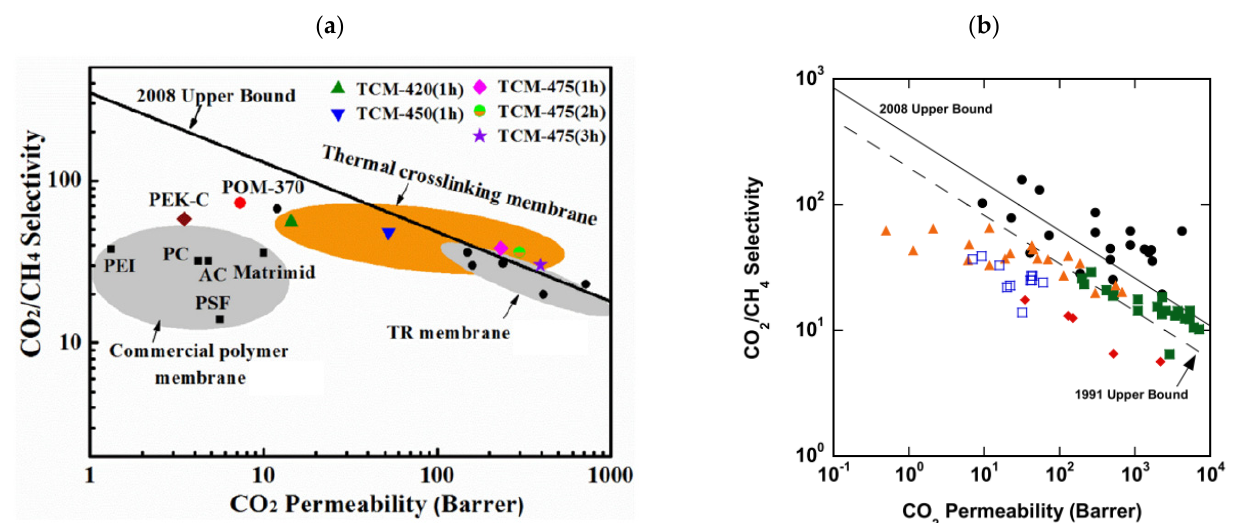
Figure 9. Illustration of thermal cross-linking and TR membranes on the 2008 upper Robeson plot. ( a ) POM-370—(TR PEK-C with oxidative pretreatment; TCM-X(y)—(TR PEK-C with thermal treatment at x °C (y hours), [103] ( b ) CO 2 /CH 4 separation performance of several polymer materials described in the literature. TR polymers ( ● ), PIMs ( ■ ), Perfluoropolymers ( ◆ ), Polyimides ( ▲ ) Poly(RTIL)s ( □ ), [23].